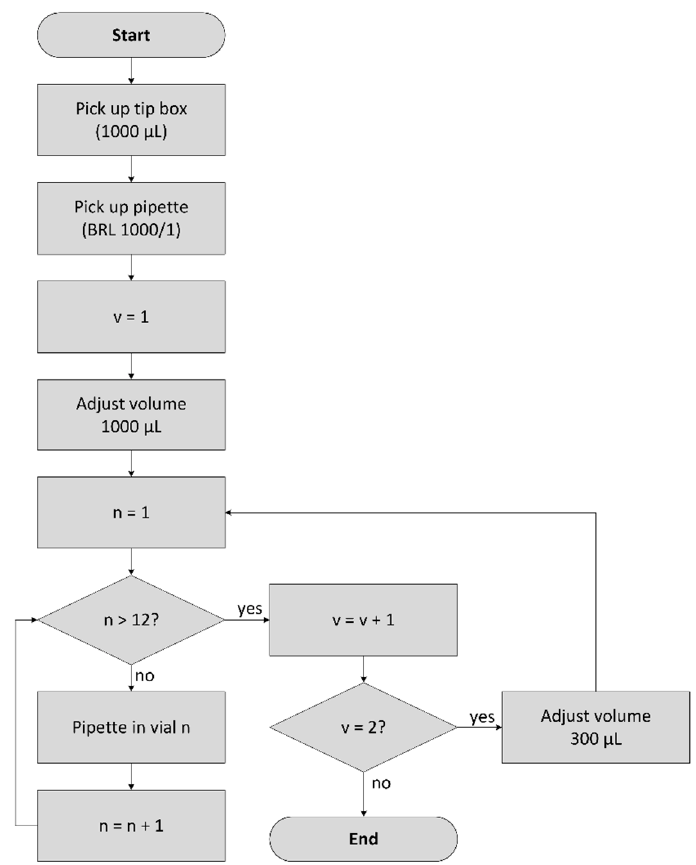
Figure 16. Process workflow of pipetting a volume of 1300 µL using one electronic pipette in two pipetting steps. Table 9. Process comparison for pipetting using manual and electronic